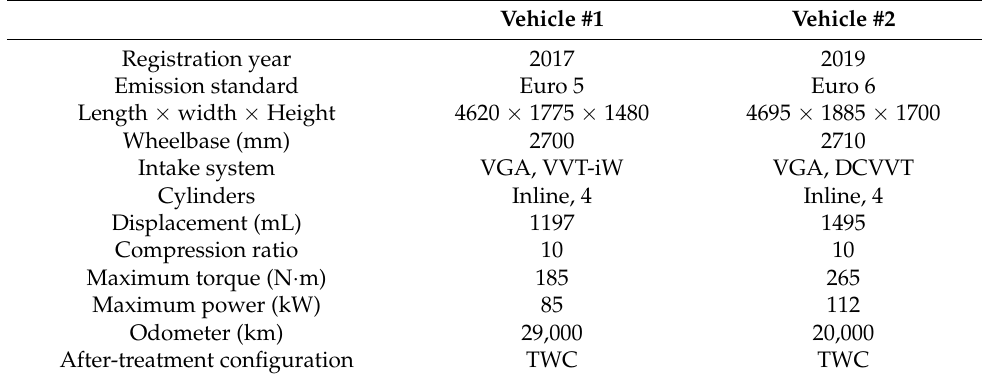
Table 2. Specifications of test